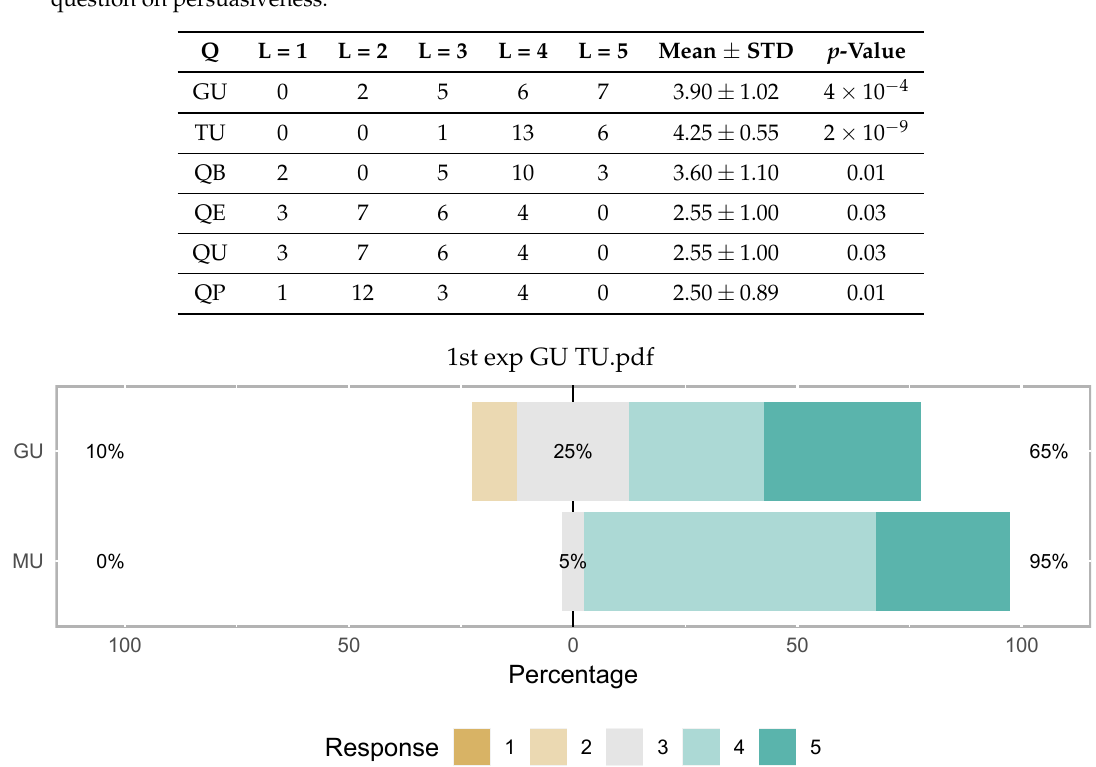
Table 2. Distribution of the users’ responses to the Likert-scale questions of Experiment 1. We report